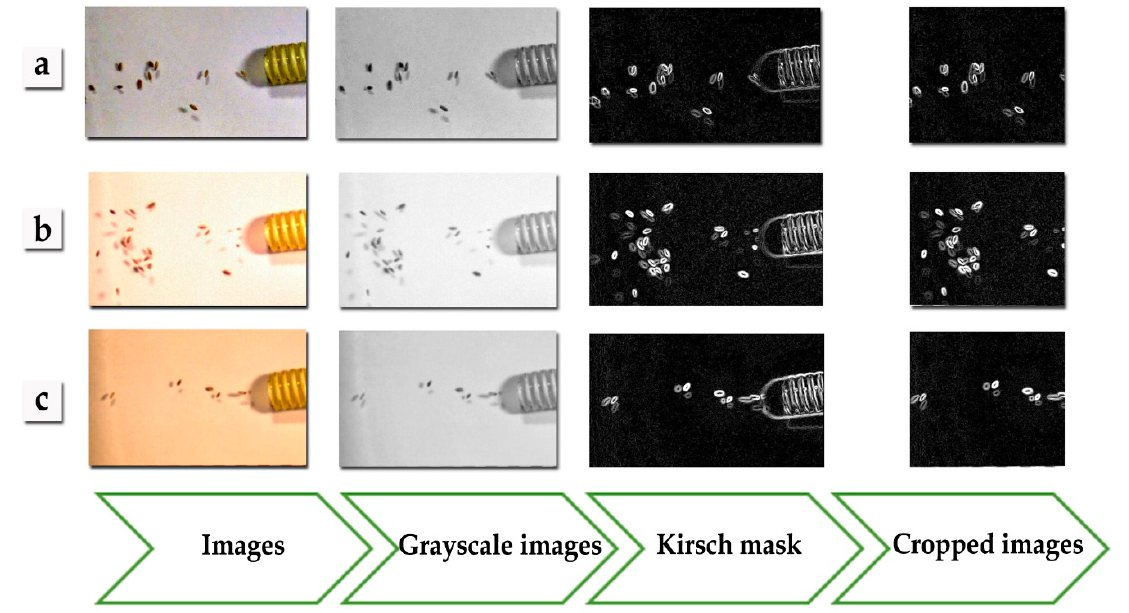
Figure 1. An example of creating a photo pattern for the select triticale class, with seed transport speeds of: ( a ) 15 m/s, ( b ) 20 m/s and ( c ) 25 m/s.